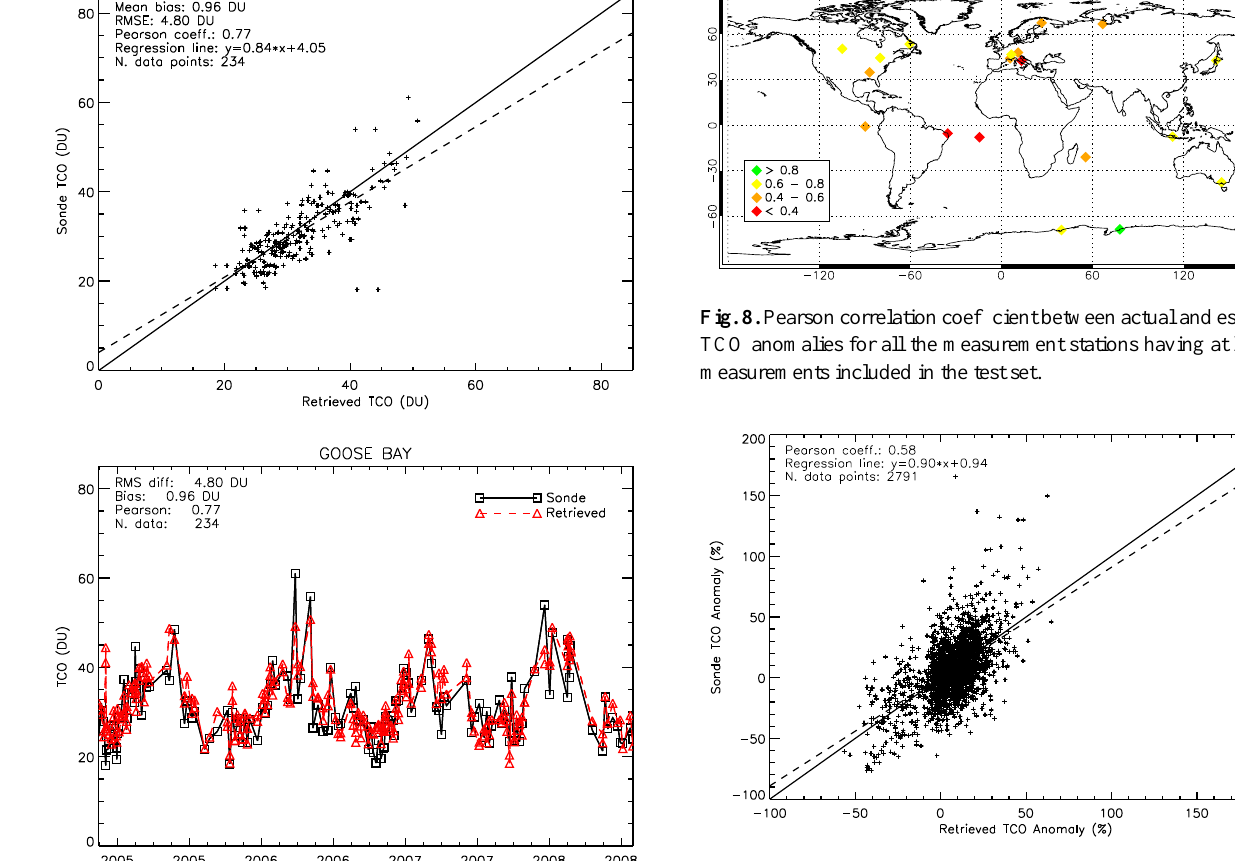
Fig. 9. Comparison between actual and estimated TCO anomaly for the NN trained only with ancillary